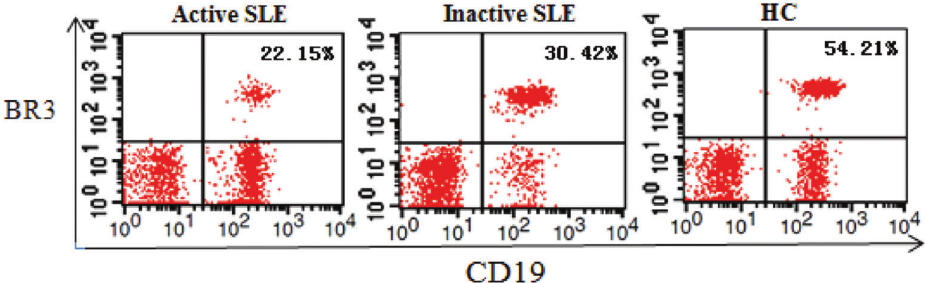
Figure 2. Representative fl uorescence-activated cell sorting dot plots of each experimental group. The expression rate of BAFF receptor 3 (BR3) on CD19 + B cells is shown in the three groups. SLE: systemic lupus erythematosus; HC: healthy control.